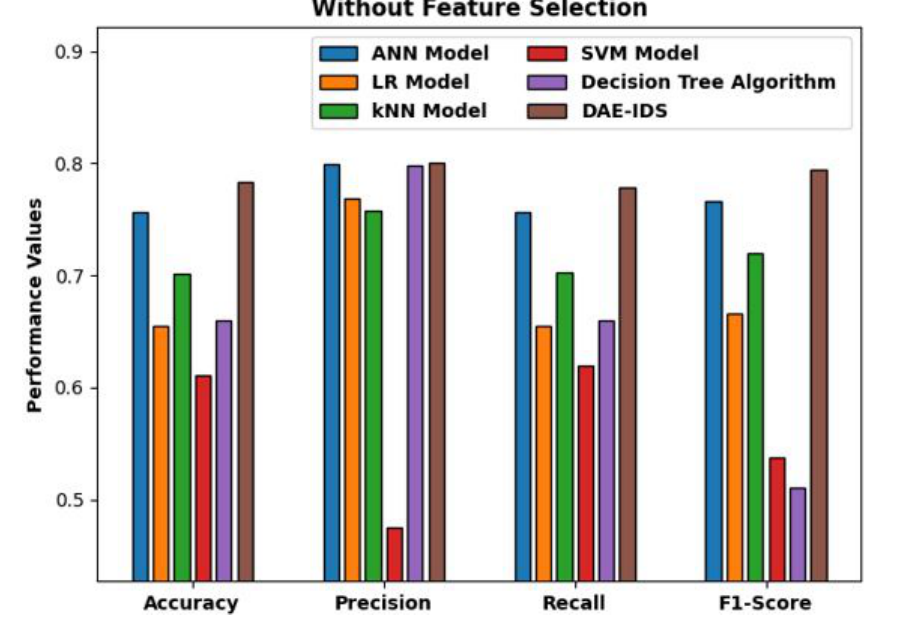
Figure 11. Comparative analysis of DAE-IDS technique without feature selection. Table 4. Comparative analysis of DAE-IDS technique without feature selection.